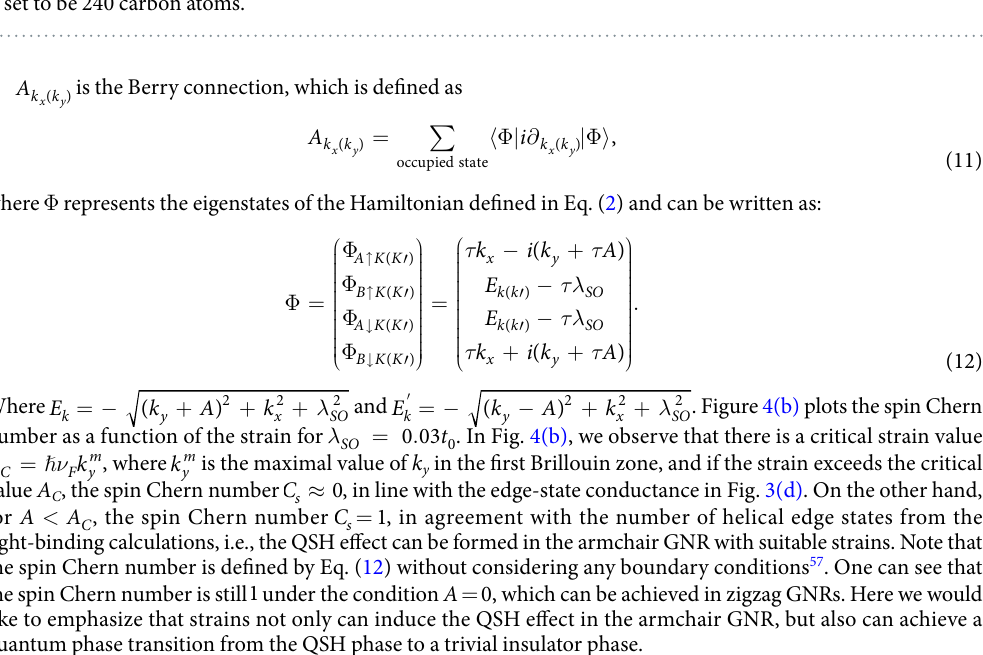
is the Berry connection, which is defined as A k k ( ) x y